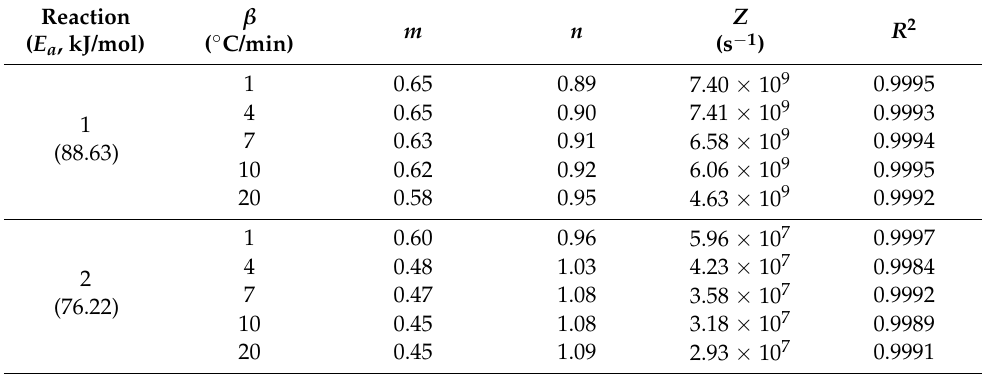
Table 2. Kinetic parameters for the Aerotuf resin, by considering the autocatalytic model. The average activation energy was obtained by the Ozawa